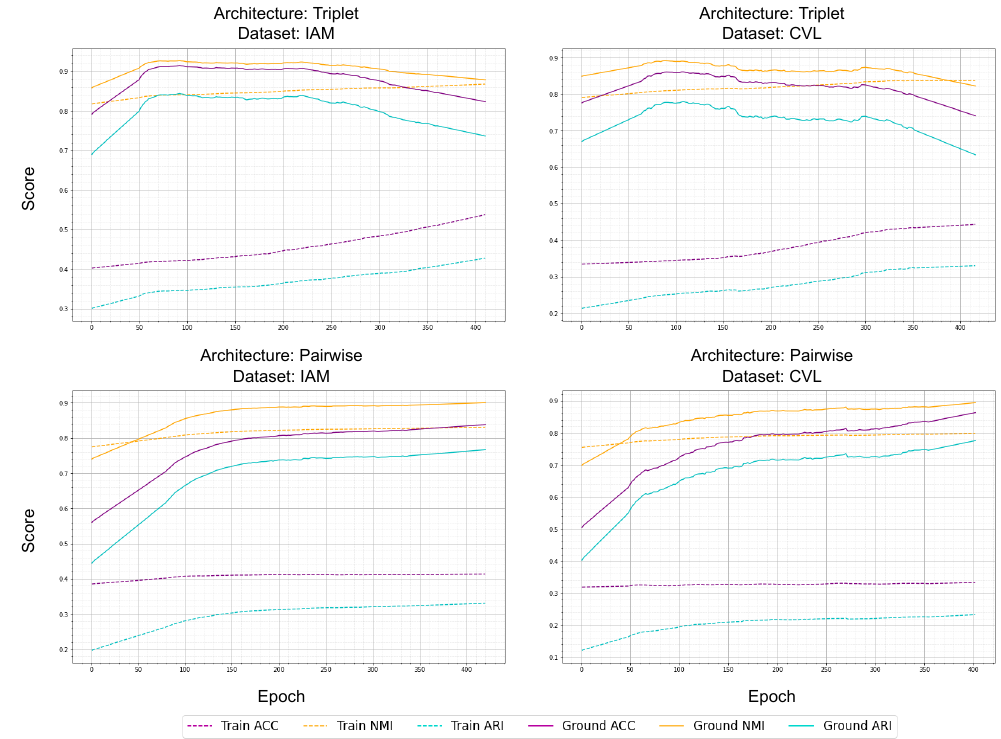
Figure 9. Graphs illustrating the metrics of the pretext task and the ground dataset containing 50 writers with impurity 0.1. The first row represents the triplet network and the second row represents the pairwise network,